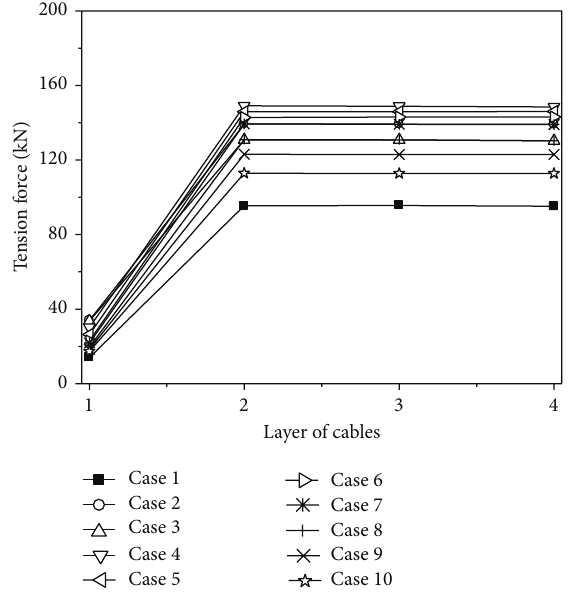
Figure 7: Tension forces of the cables under different traveling wave